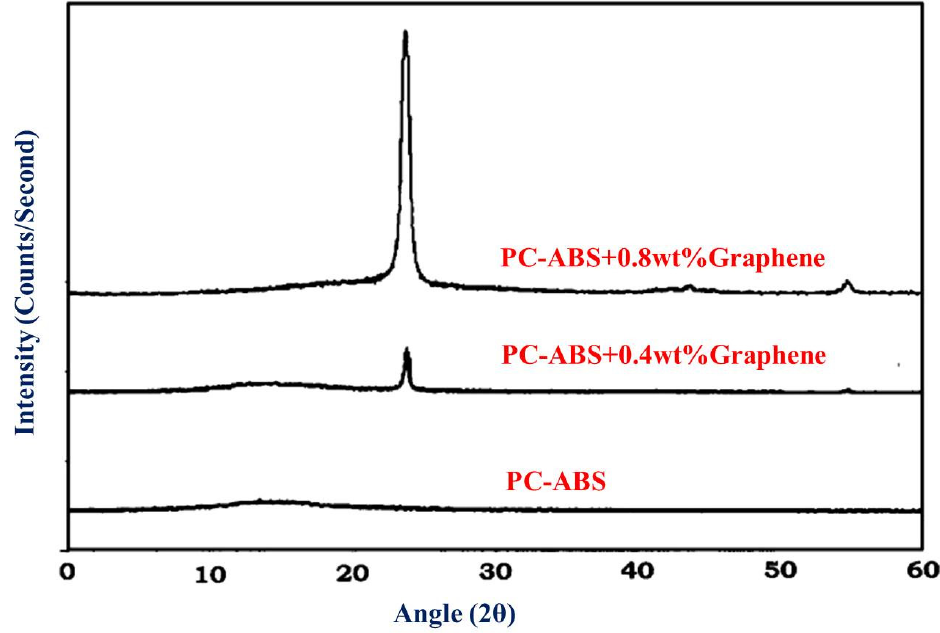
Figure 11. XRD of PC-ABS, PC-ABS + 0.4 wt % graphene, and PC-ABS + 0.8 wt % graphene.